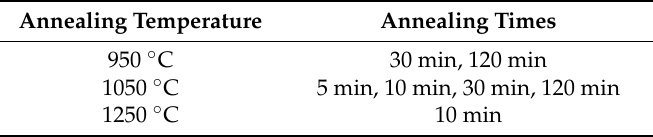
Table 1. The annealing parameters of the 70% clock-rolled Ta